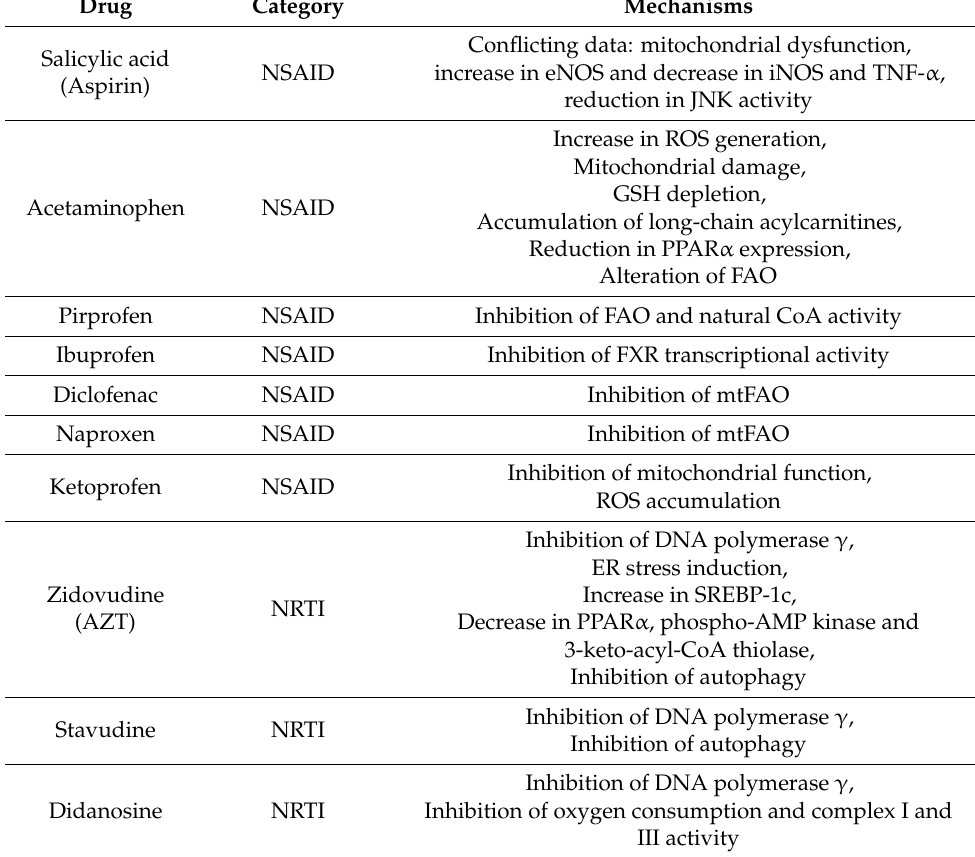
Table 1. Cont. Drug